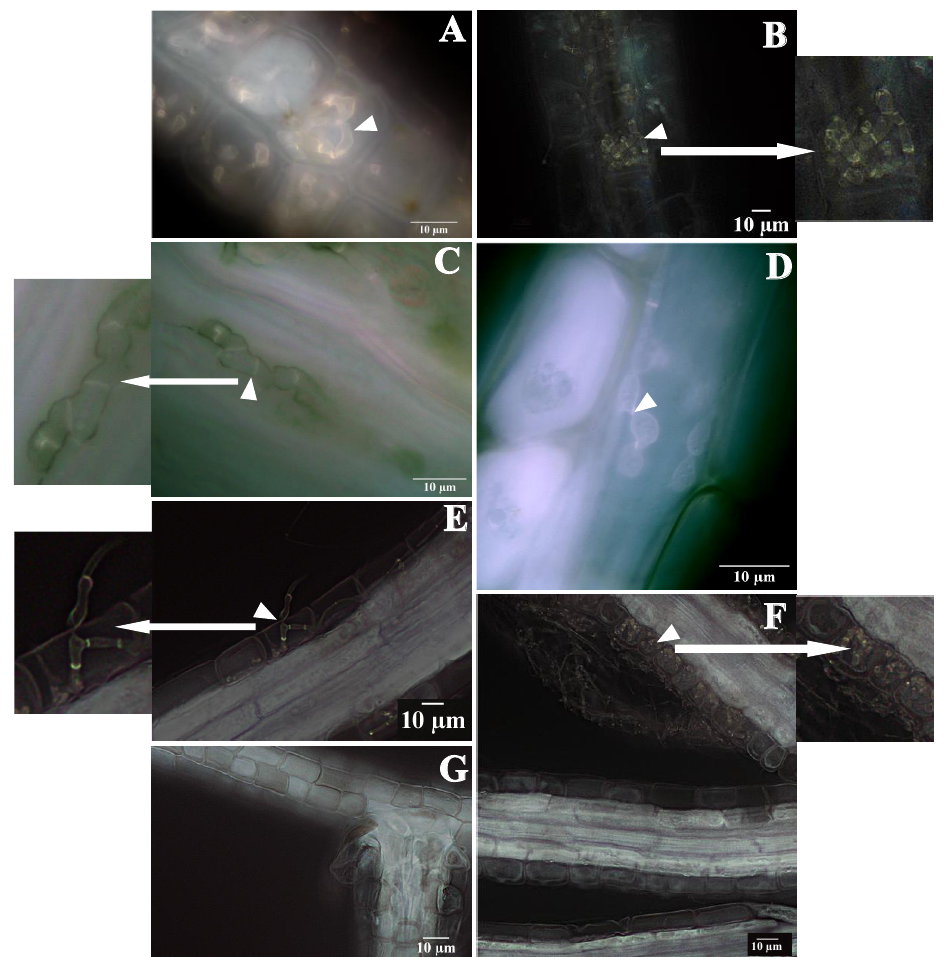
Figure 2. Microscopy of cranberry roots colonized by EC4. Plant tissues and fungal hyphae were differentially stained using solophenyl flavine and Safranin and inspected by light and fluorescent microscopy. ( A , B ) Loose hyphal coils of EC4 (arrowheads) inside cranberry root cells. ( C , D ) EC4 hyphae with thick, melanized septate hyphae (arrowheads). ( E ), EC4 hyphae (arrowhead) inside an epidermal cell of the host root. ( F ) EC4 hyphae (arrowhead) wrapped around the plant’s roots. ( G ) Roots of control plant not inoculated with EC4.